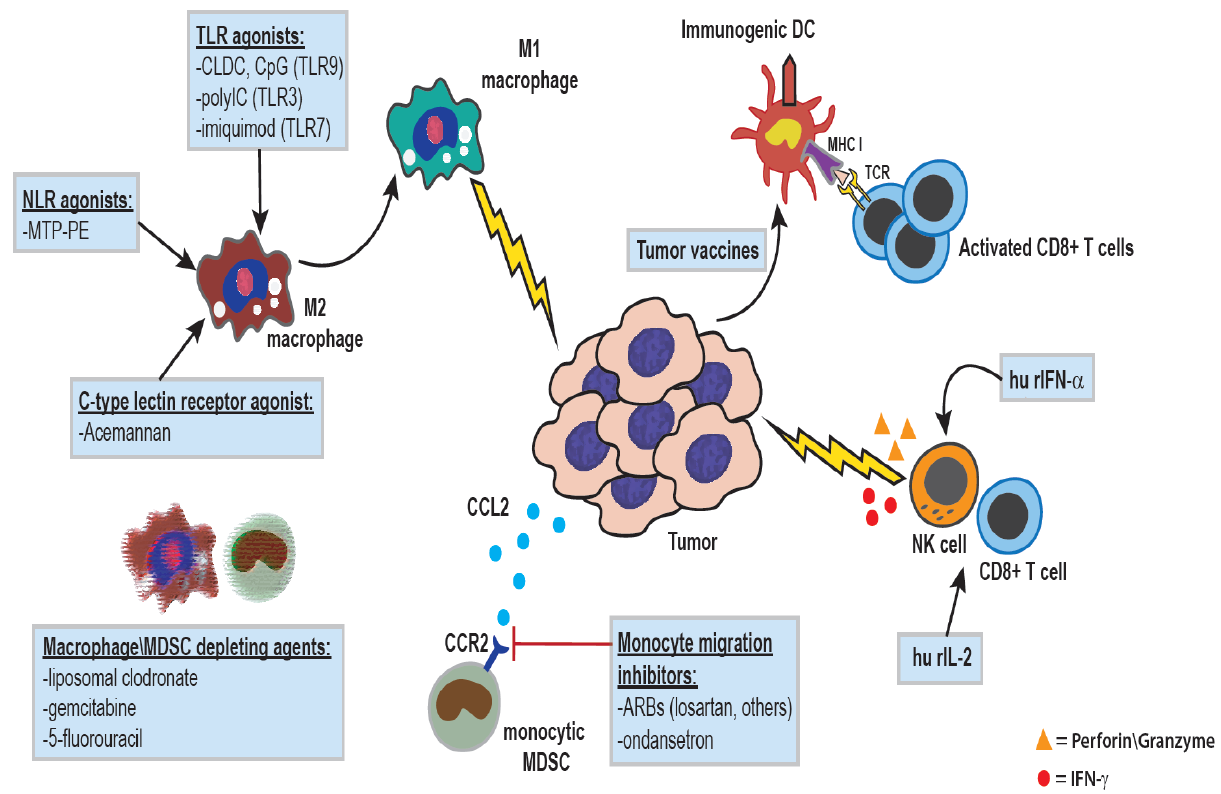
Figure 3. Therapeutic manipulations of the innate immune system for treatment of cancer: The administration of agonists for various pattern-recognition receptors, including Toll-like receptors (cationic liposome-DNA complexes (CLDC), pIC, or imiquimod), Nod-like receptors (liposomal muramyl tripeptide), or lectin receptors (acemannan), can result in macrophage activation and polarization towards a pro-inflammatory anti-tumor phenotype. IL-2 is a potent activator of NK and T cells, and human recombinant IL-2 has been used in the treatment of multiple canine cancer types including melanoma, metastatic osteosarcoma, lymphoma, and soft tissue sarcoma. Type I interferons such as IFN-α serve to activate and enhance DC maturation, and increase cytotoxicity of CD8+ T cells and NK cells, and recombinant human IFN-α has been administered to dogs with various epithelial neoplasms. Macrophages and monocytes can also be targeted with various drugs as a means of augmenting tumor angiogenesis and restoring anti-tumor immunity. Drugs such as liposomal clodronate or conventional chemotherapeutics like gemcitabine and